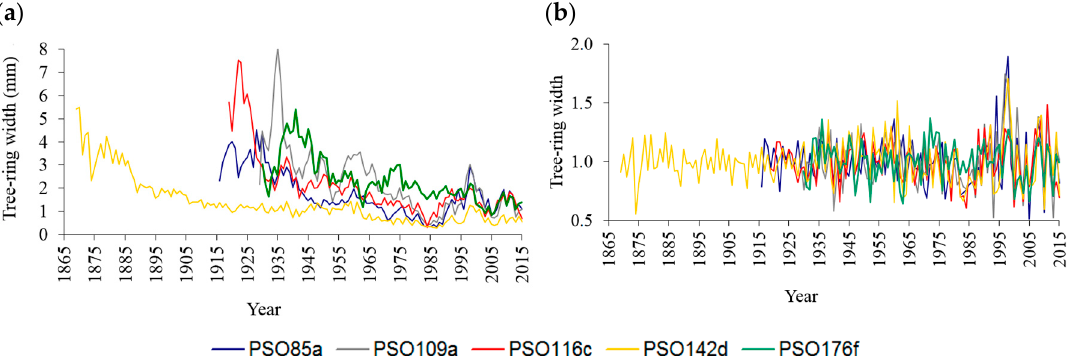
Figure 5. Raw ( a ) and residual ( b ) site chronologies of Scots pine (PSO) 1869–2015.